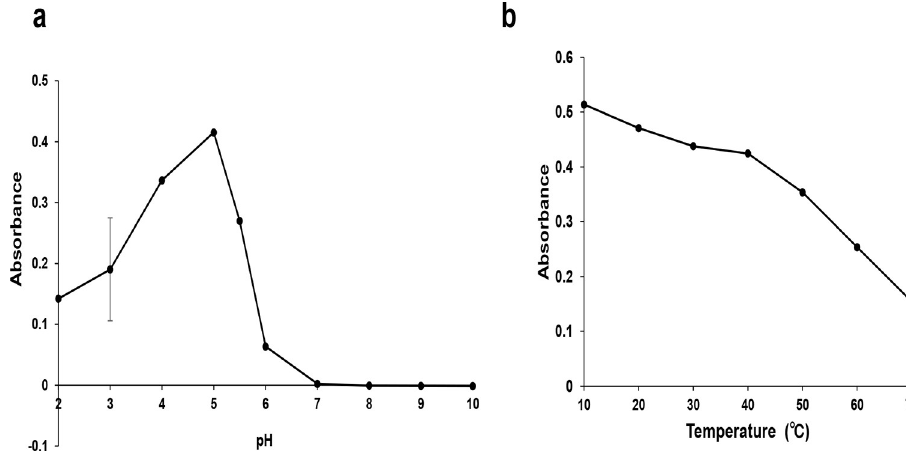
Fig 4. Effects of temperature and pH on absorbance values of Trp. Change in the absorption intensity (525 nm) of Trp solution (50 mg/L) (a) at different pH and (b) different temperatures, after the addition of 400 g/L of MSG, 10% HCl, and 5% NaOCl � 5H 2 O. Results are the mean ± S.D. of three